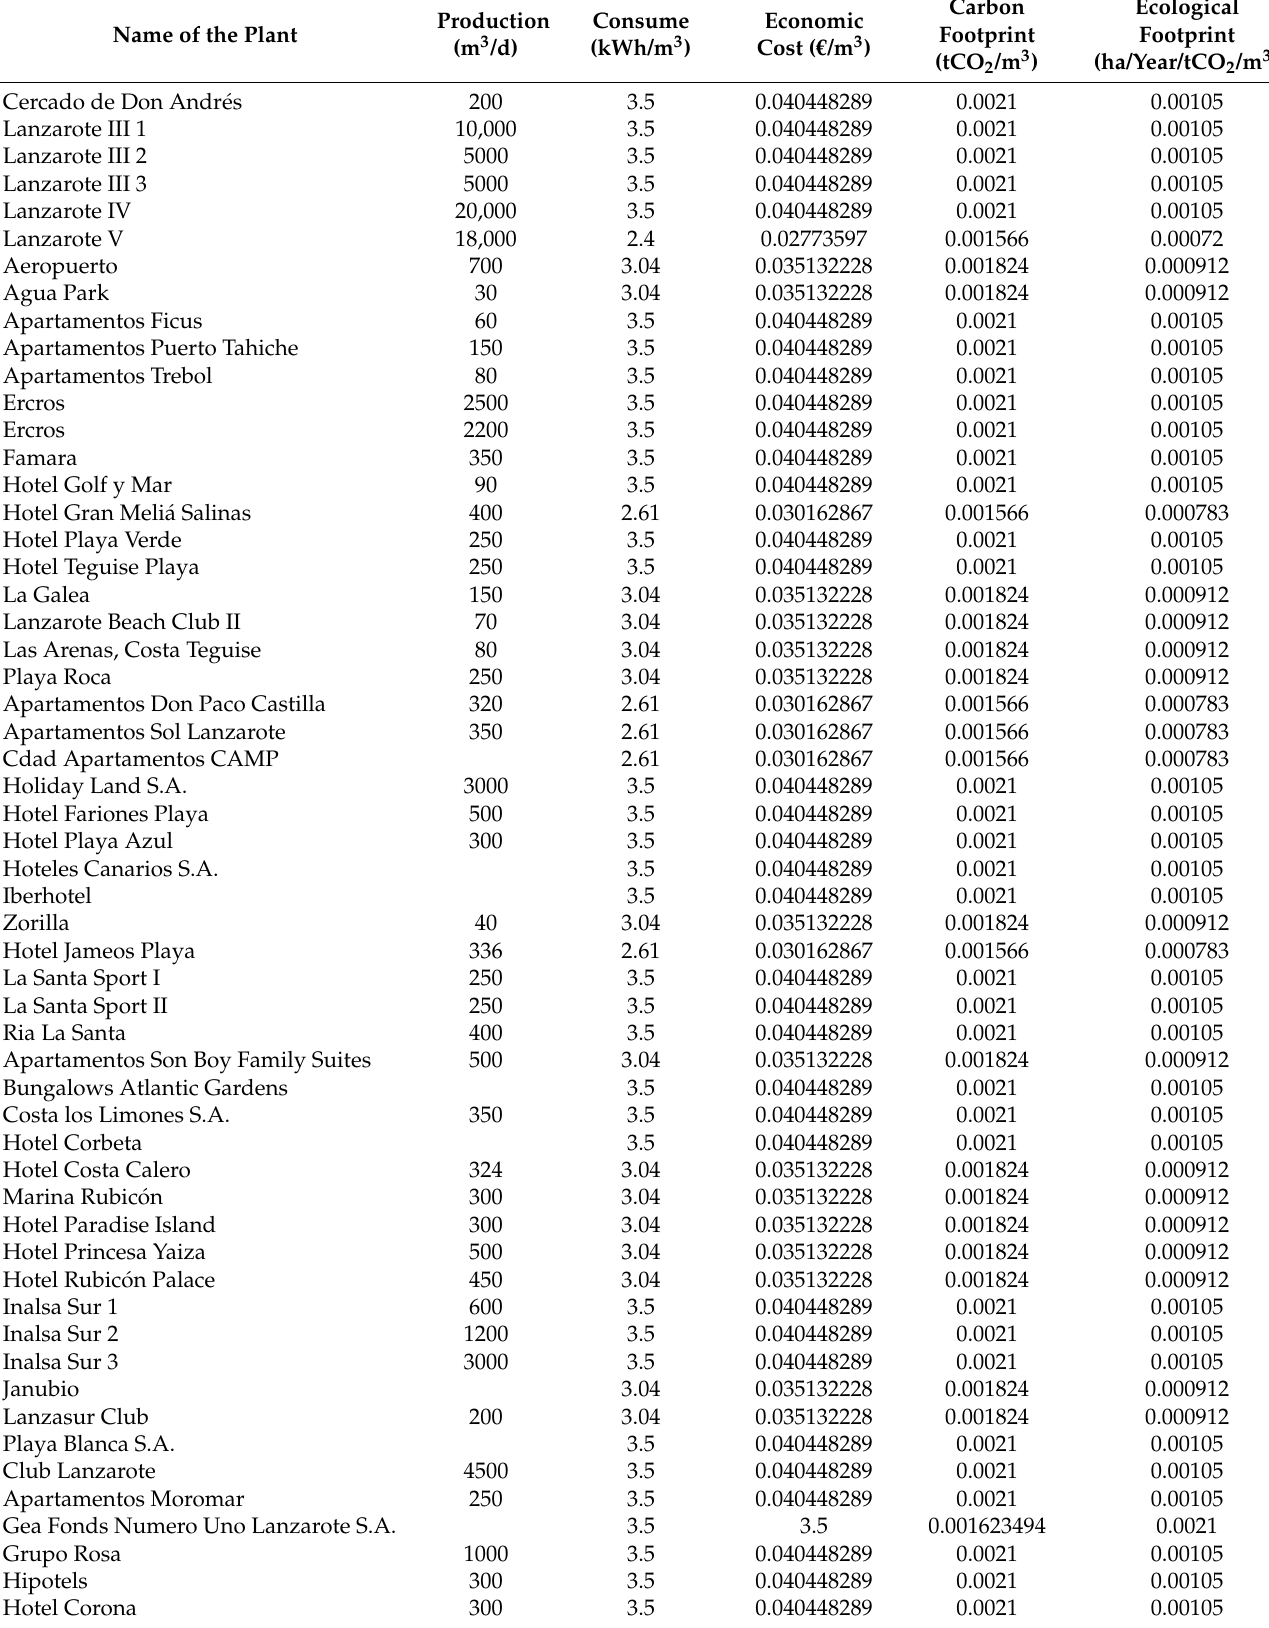
Table 7. Existing seawater desalination plants in the Canary Islands. Source: FCCA 2013 and REE